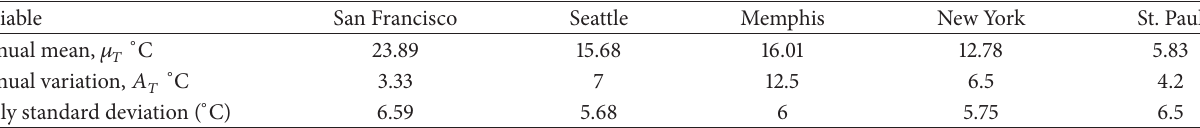
Table 4: Thermal load related statistics